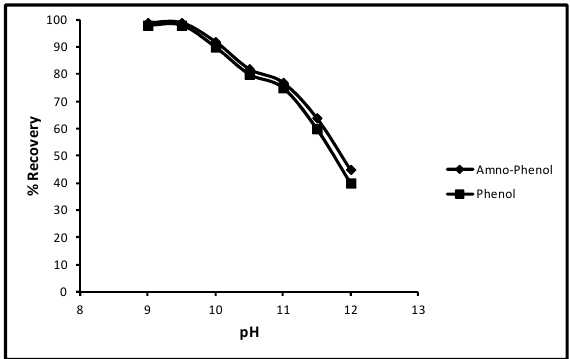
Figure 7. Effect of pH for desorption of phenols.